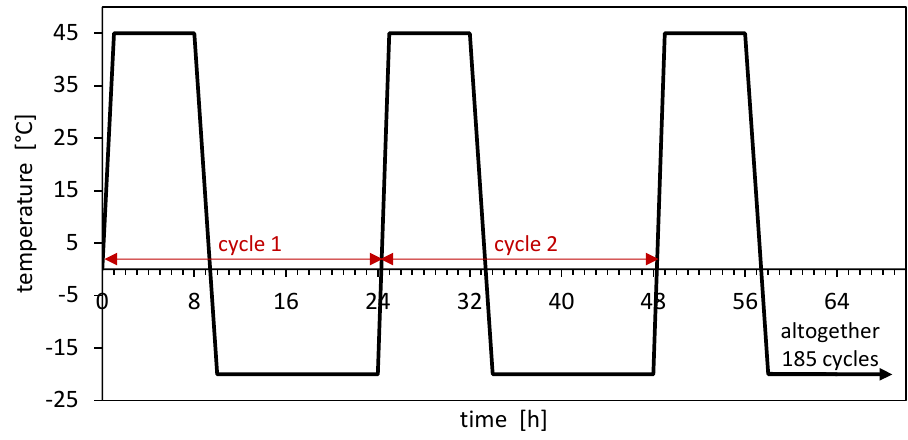
Figure 4. Schematic temperature cycles of freeze-thaw tests for the modified testing procedure.